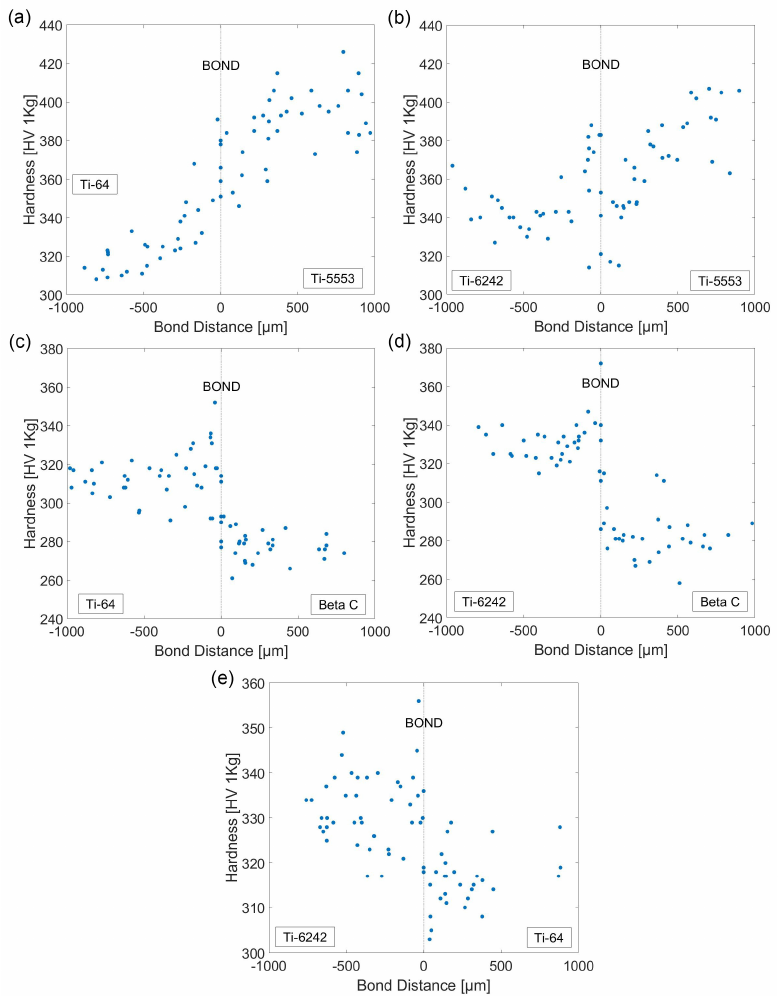
Figure 5. Hardness profiles (HV 1 kgf) for a range of titanium alloy diffusion bond pairings FAST processed at 970 ◦ C and for a dwell time of 25 min. ( a ) Ti-64/Ti-5553, ( b ) Ti-6242/Ti5553, ( c ) Ti-64/Beta C, ( d ) Ti-6242/Beta C and ( e )